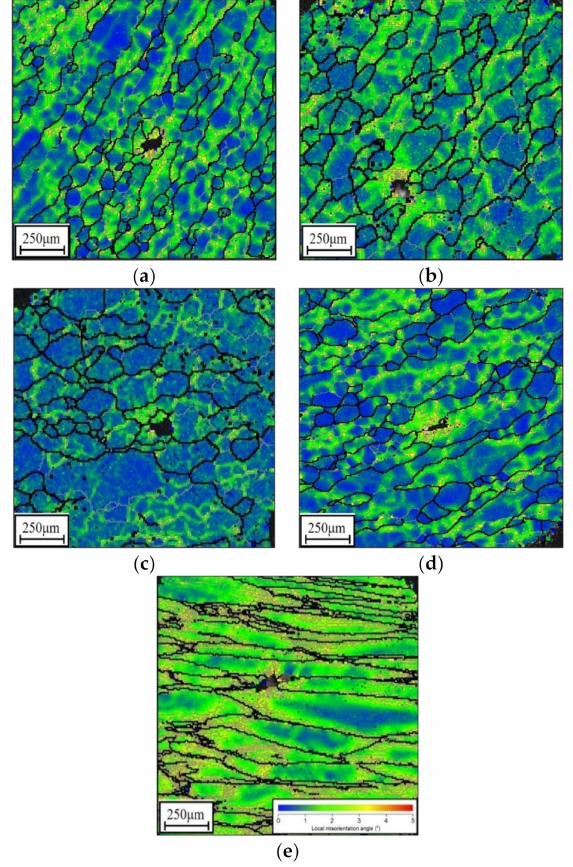
Figure 5. EBSD KAM maps at: ( a ) 890 ◦ C/0.1 s − 1 / ε I = 0.3/0.001 s − 1 , ( b ) 920 ◦ C/0.1 s − 1 / ε I = 0.3/0.001 s − 1 , ( c ) 950 ◦ C/0.1 s − 1 / ε I = 0.3/0.001 s − 1 , ( d ) 920 ◦ C/0.1 s − 1 / ε I = 0.9/0.001 s − 1 , ( e ) 920 ◦ C/0.1 s − 1 / ε I = 0.3/1 s − 1